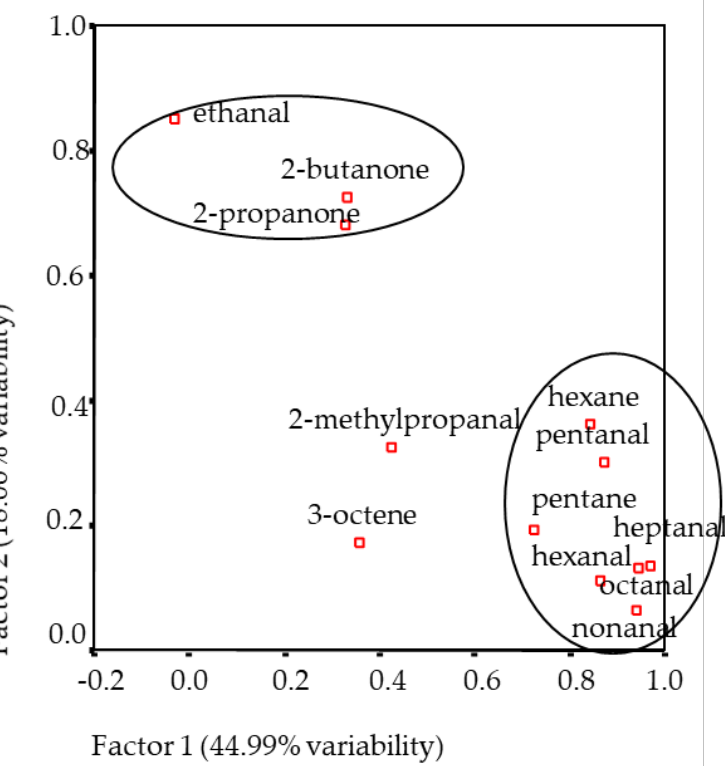
Figure 1. Plot of the volatile compounds from the headspace of the Longissimus thoracis muscle from Navarra breed lambs on the bidimensional space formed by factors 1 and 2.